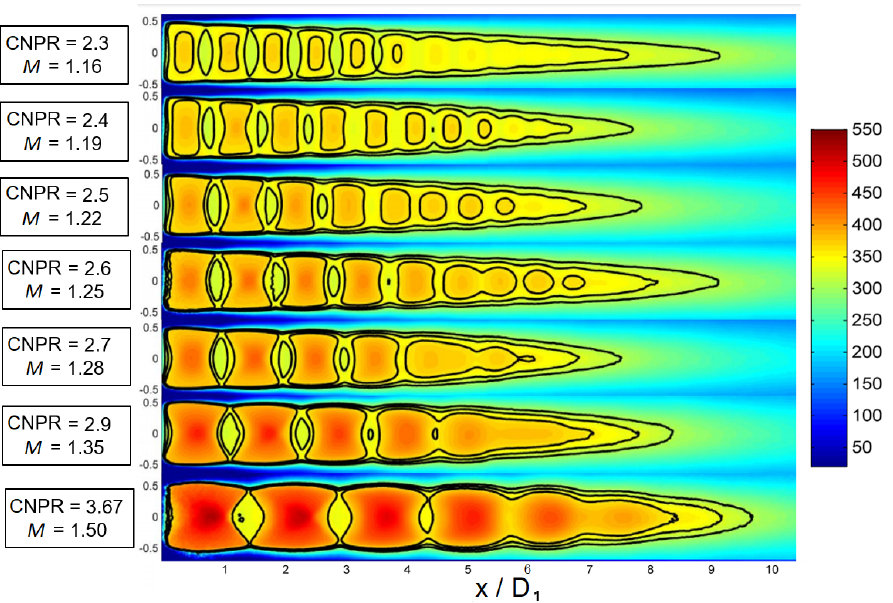
Figure 17. Overview of the averaged velocity field for all the conditions investigated. Black isocontour lines identify M = [0.9 1.0